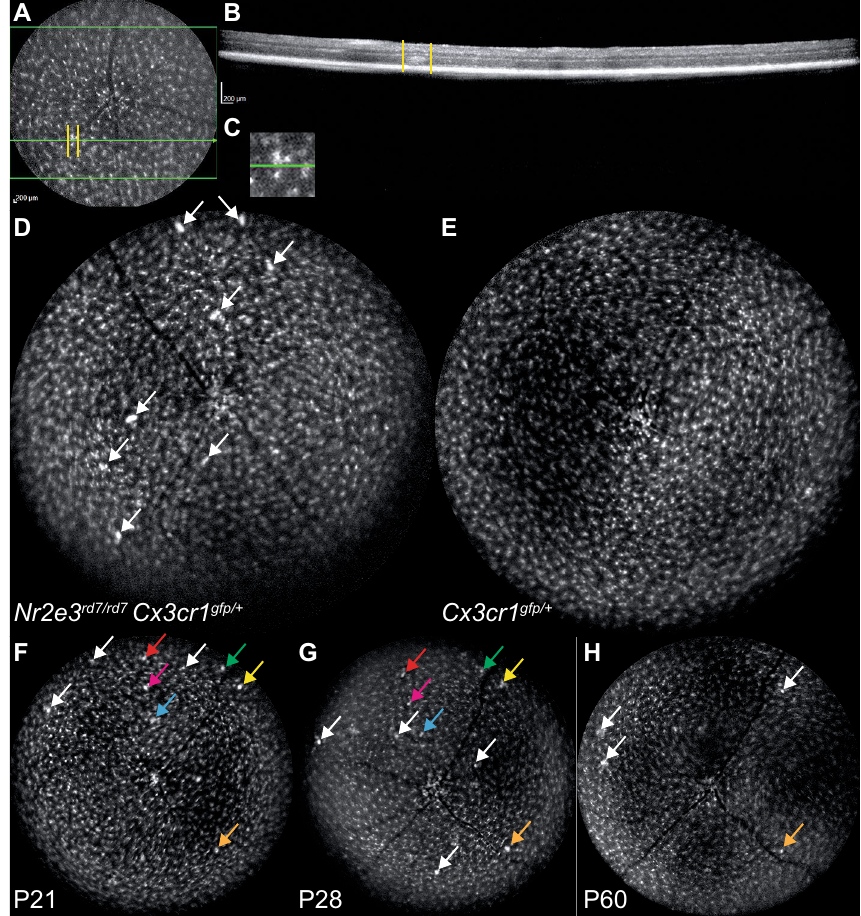
Figure 3. In vivo imaging of Iba1 expressing cells in Cx3cr1 gfp/ + and Nr2e3 rd7/rd7 Cx3cr1 gfp/ + retinas. Fundus autofluorescence imaging of Nr2e3 rd7/rd7 Cx3cr1 gfp/ + retinas identify GFP-positive cells as a white signal ( A ). Hyperautofluorescent signals colocalize with ‘rosettes’ on OCT B-scans ( B ; scan indicated by green line and ‘rosette’ delimitated by yellow bars) and magnification shows accumulation of individual hyperautofluorescent cells ( C ). Multiple hyperautofluorescent signals are detected at P28 by fundus autofluorescence imaging of Nr2e3 rd7/rd7 Cx3cr1 gfp/ + retinas ( D ; white arrows), but not Cx3cr1 gfp/ + retinas ( E ). Longitudinal in vivo analysis of hyperautofluorescent signals in Nr2e3 rd7/rd7 Cx3cr1 gfp/ + retinas at P21 ( F ), P28 ( G ) and P60 ( H ). Unique signals are indicated by white arrows, repeatedly detected signals by color-coded